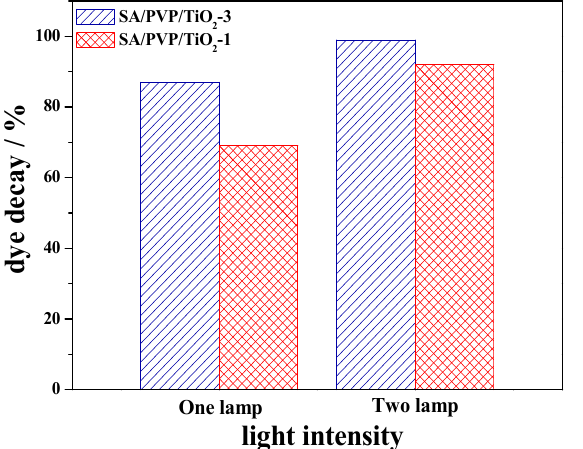
Figure 6. Effect of the light intensity on MB photocatalytic degradation using SA/PVP/TiO 2 nanocomposite (pH 7; 120 min of illumination time; and 50 mg L − 1 initial MB concentration).